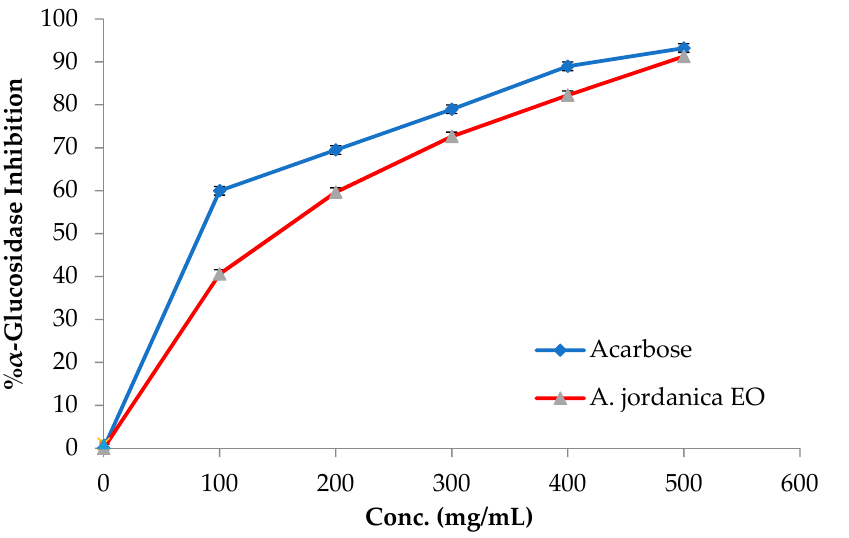
Figure 5. α -Glucosidase inhibitory activity by Artemisia jordanica essential oil and acarbose.